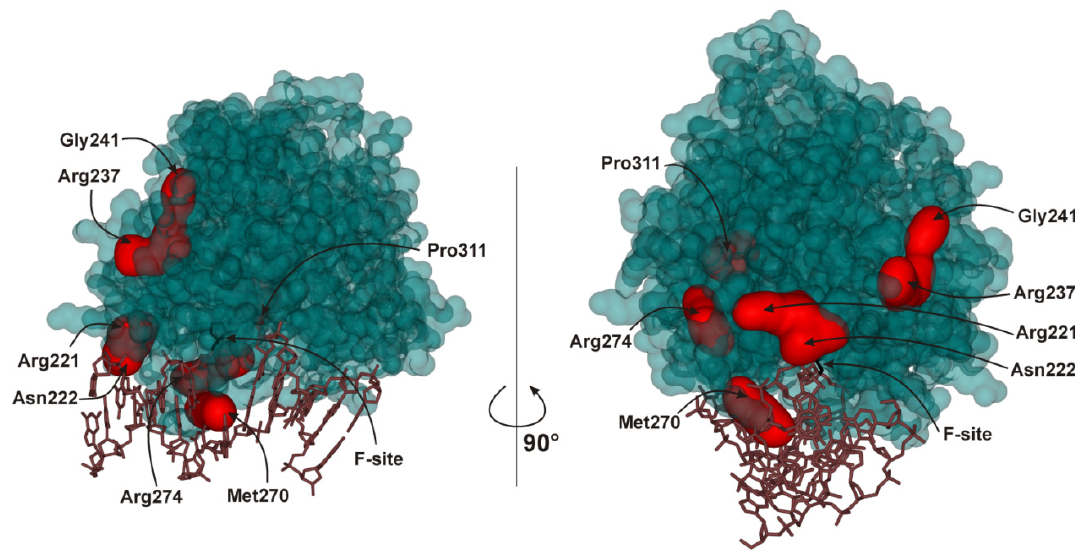
Figure 1. Spatial location of the amino acid residues affected by the SNPs of APE1 (PDB ID 1DE8).